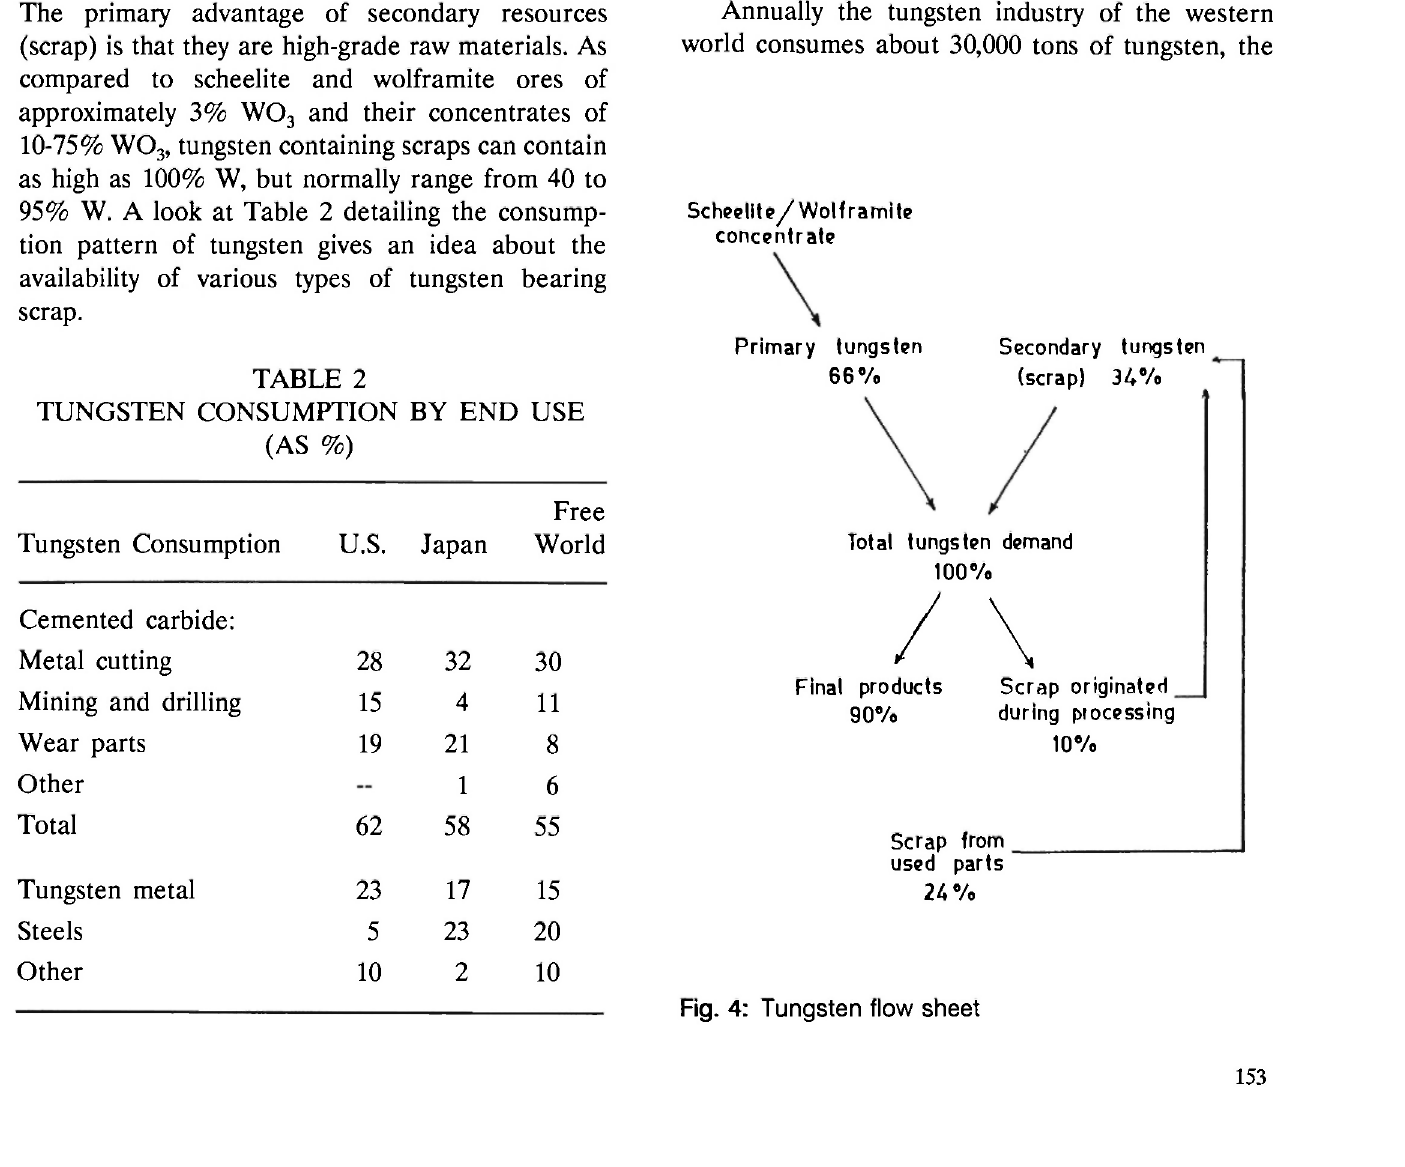
Fig. 4: Tungsten flow